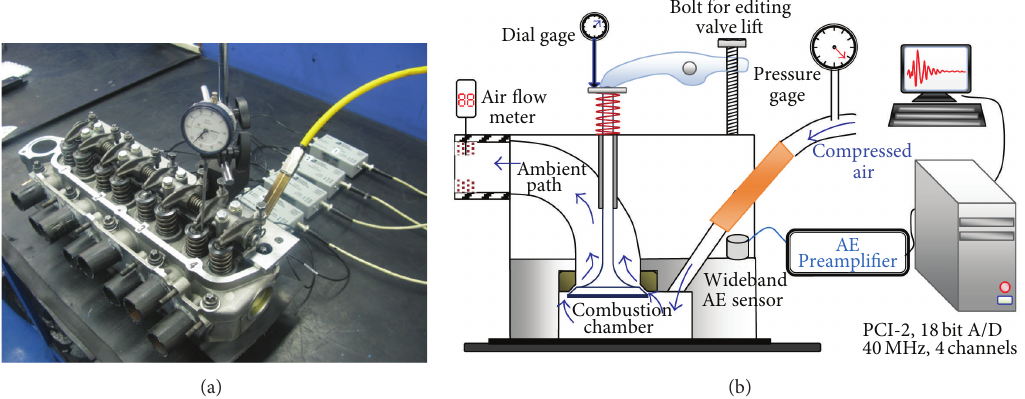
Figure 1: Test rig overview. (a) AE sensors positions and (b) schematic of measurement